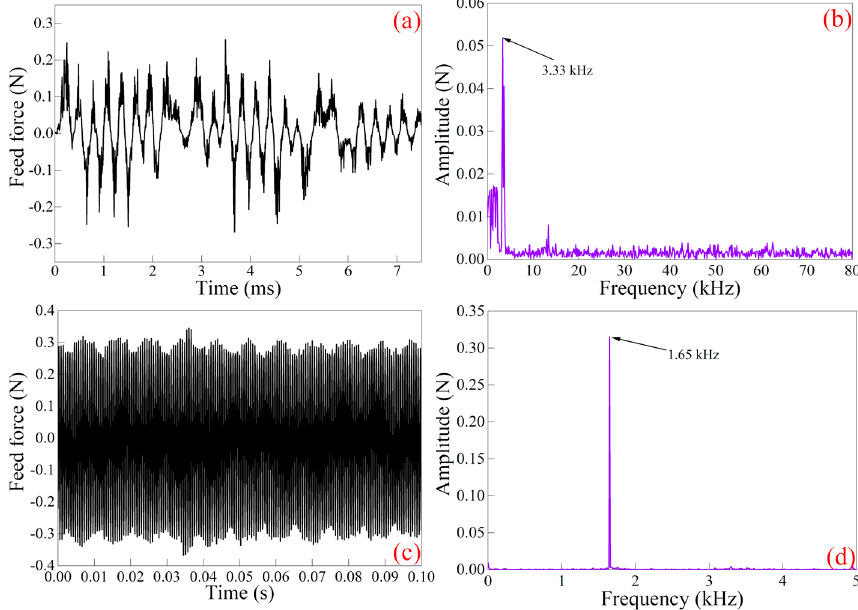
Figure 4. Variation in feed force with time in ( a ) FE and ( c ) experiment simulation of micro-milling; FFT analysis of feed force in ( b ) FE simulation and ( d ) experiment.